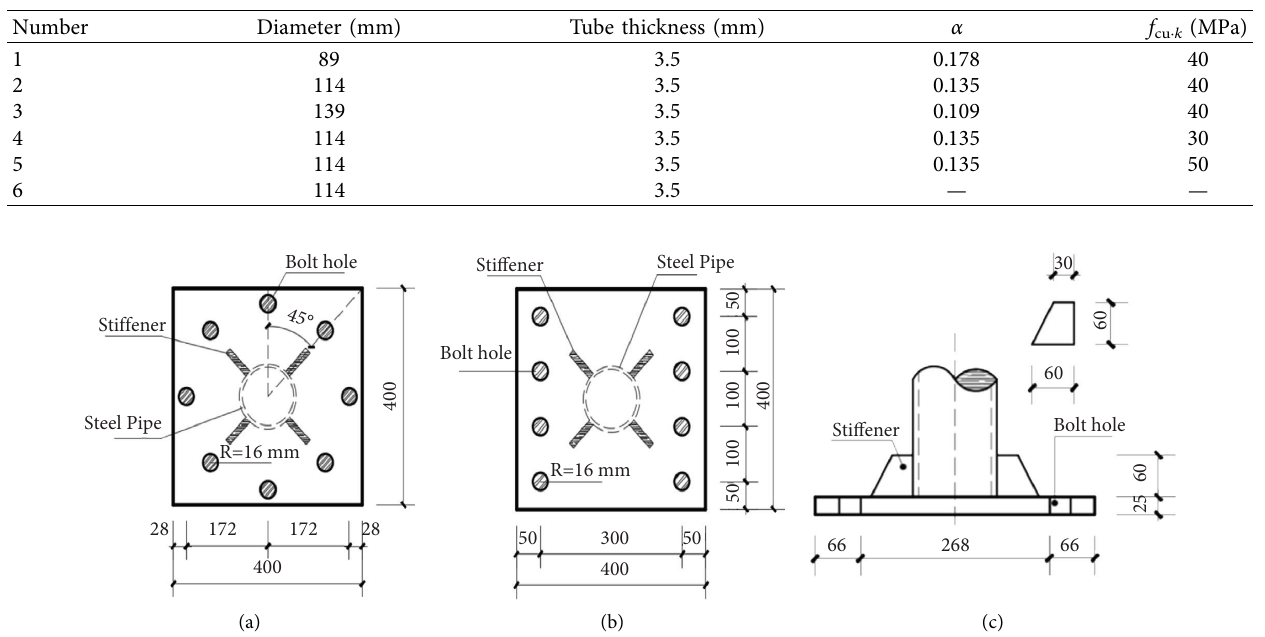
Table 1: Specimen parameter.